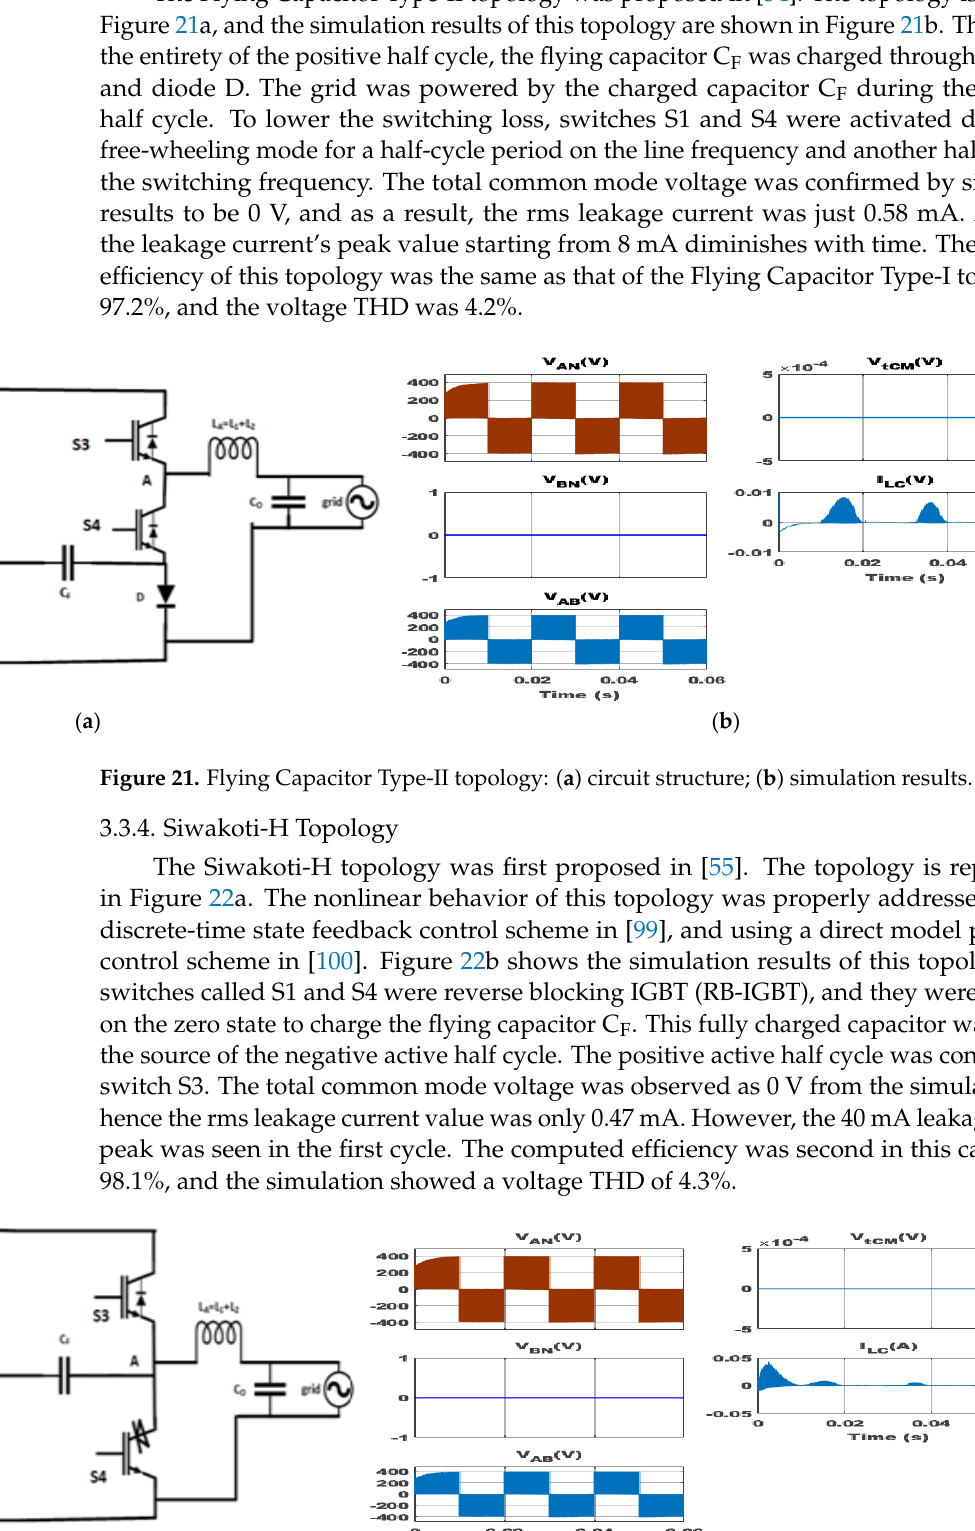
Figure 20. Flying Capacitor Type-I topology: ( a ) circuit structure; ( b ) simulation results.